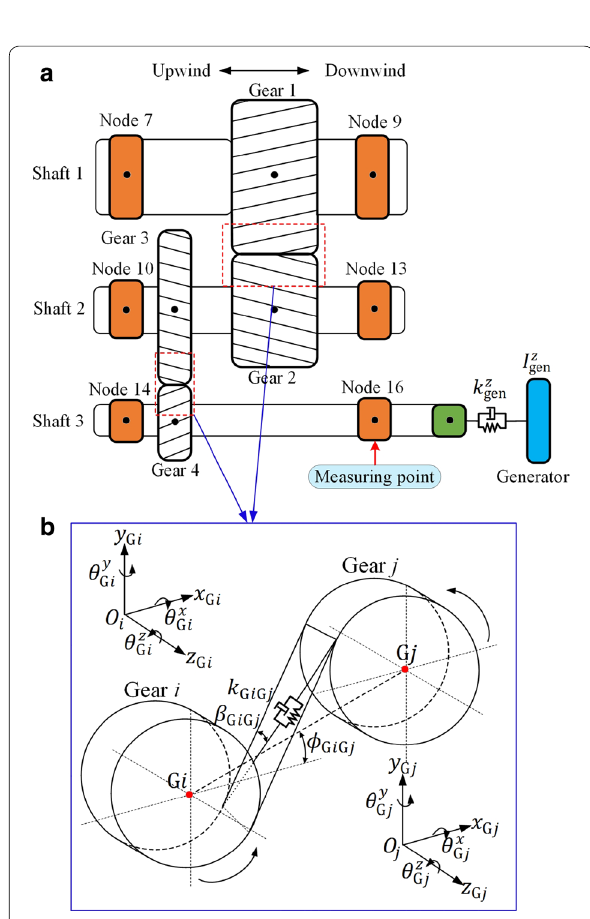
Figure 5 Lumped parameter model of parallel gear stage: a a whole structure view of parallel gear stages and b a three-dimensional model of a